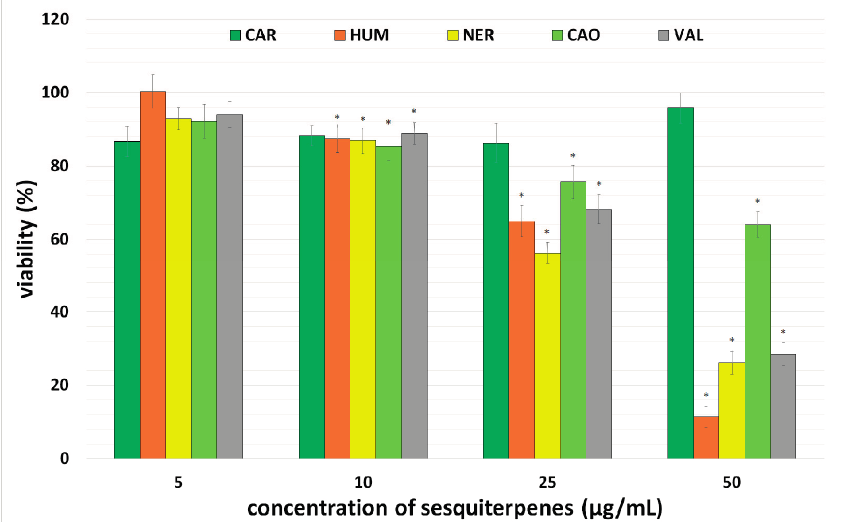
Figure 2. Effect of sesquiterpenes on the proliferation of cancer cell line CaCo-2. Viability was assayed using a NRU test. Data presented as percentage of control cells (=100%) represent the mean ± S.D. from 3 independent experiments (with 6 parallels in each). The asterisk indicates a significant difference from the control cells ( p <